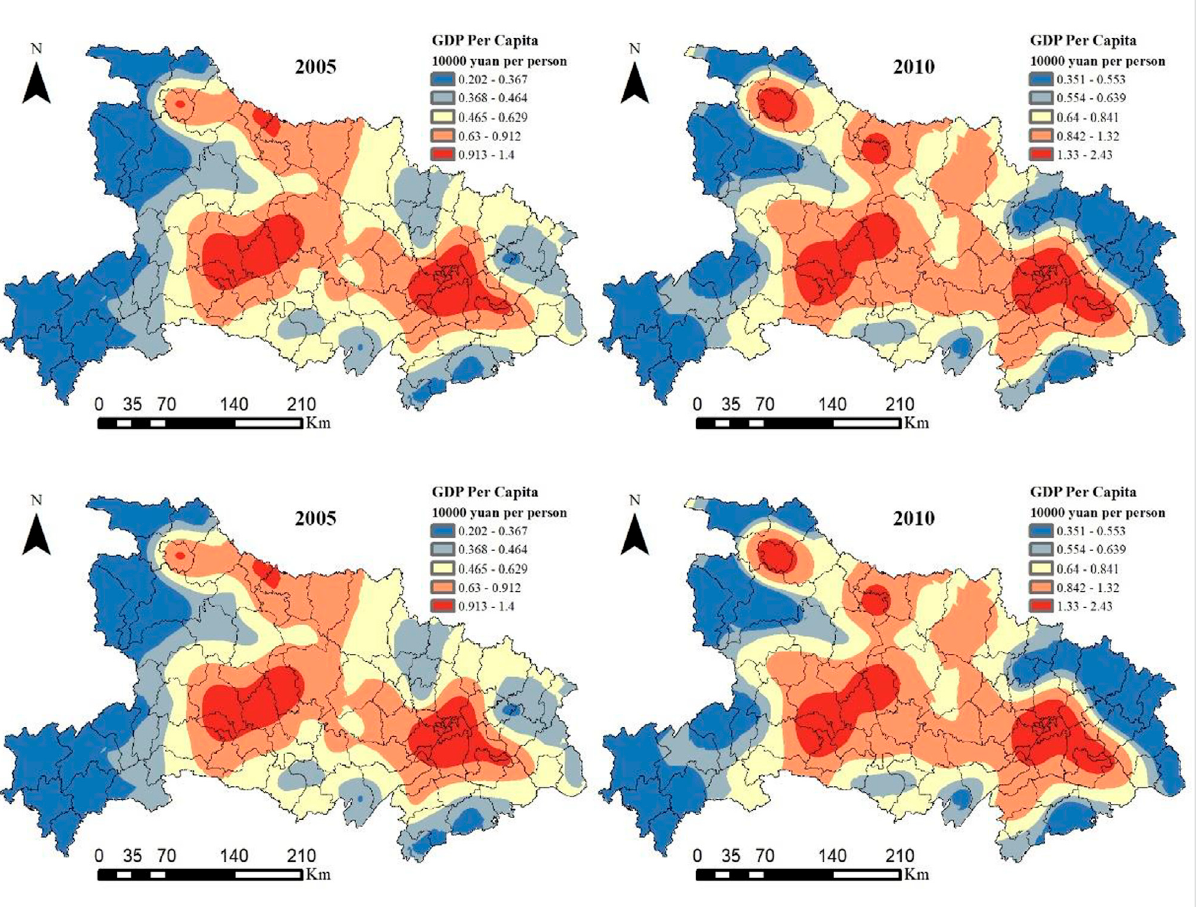
FIGURE 4 Spatial patterns of county economy in Hubei province from 2005 to 2020. (blue denotes the poor counties; gray denotes the less-developed counties; yellow denotes the well-developed counties; orange denotes the more-developed counties; and red denotes the rich